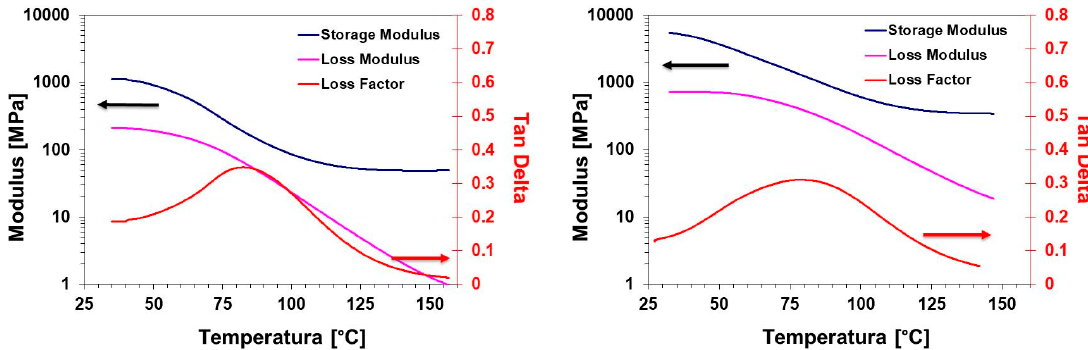
Figure 6. Dynamic mechanical analysis (DMA) results of RK ( left ) and RK-FBt20 ( right ).